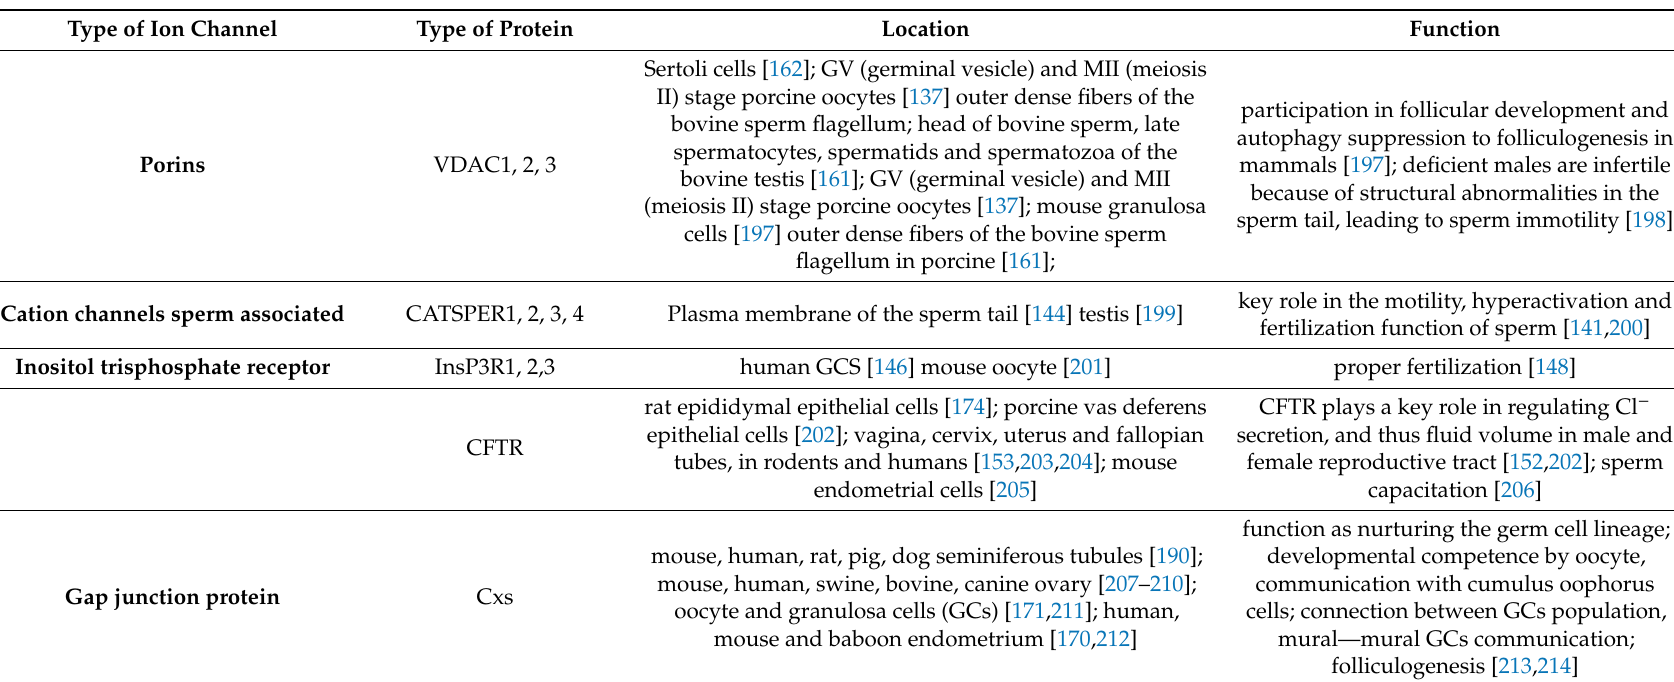
Table 2. The main types of ion channels and related proteins in the reproductive system. Numbers in brackets indicate the